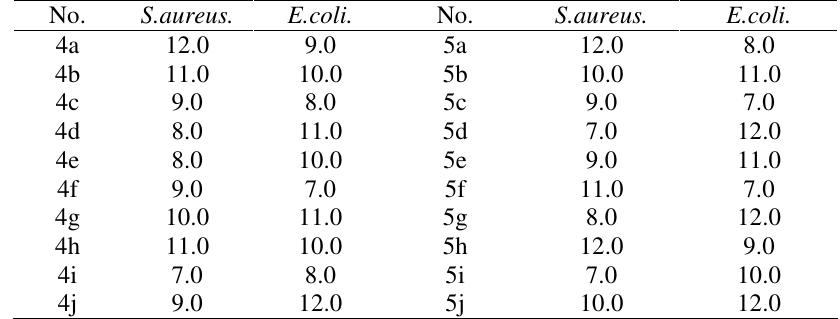
Table 3. Antibacterial activity of Newly synthesised compounds, zone of inhibition (mm) No. S.aureus. E.coli. No.